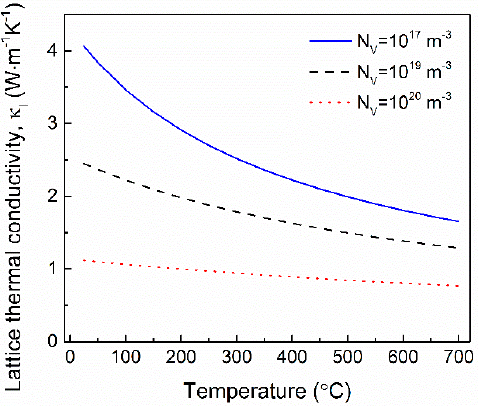
Figure 6. The temperature dependent lattice thermal conductivity values calculated based on the Callaway model for PbTe-matrix containing precipitates of 10 nm radius and three different number densities: N v = 10 17 , 10 19 , and 10 20 m − 3 , denoted by blue solid, black dashed, and red dotted lines, respectively.